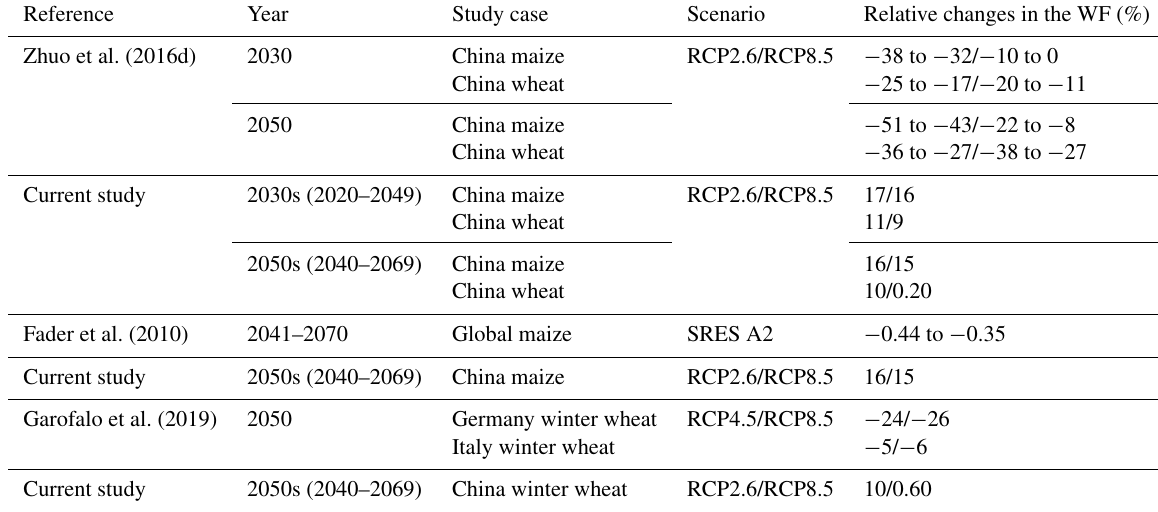
Table 4. Comparison of the results between current and previous